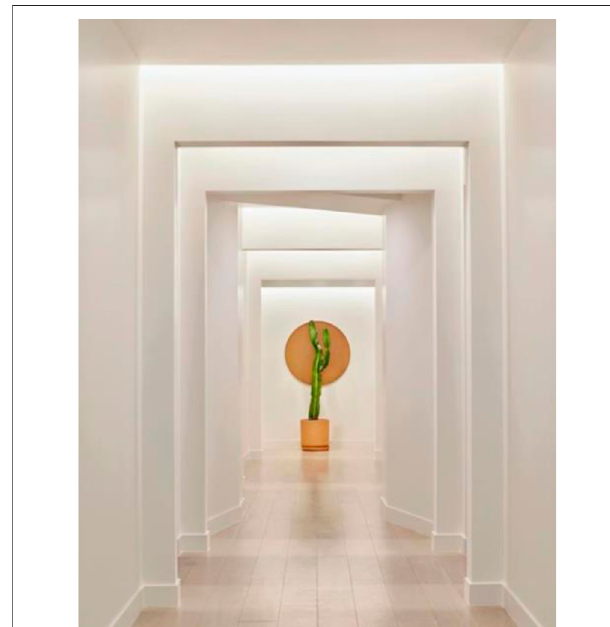
FIGURE 5 | Zen-like hallway: Credit Kara Ladd, Architectural Digest (2019), photography by Trevor Tondro.